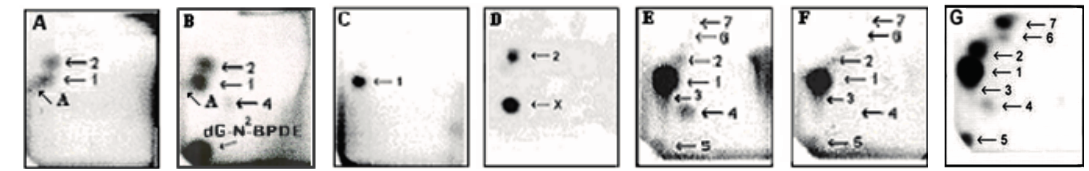
Figure 2. Autoradiographs of thin layer chromatography (TLC) maps of 32 P-labeled digests of calf thymus DNA reacted with ellipticine activated by hepatic microsomes from wild-type (WT) mice ( A ), with those from Hepatic Cytochrome P450 Reductase Null (HRN) mice pre-treated with benzo[a]pyrene (BaP) ( B ), from calf thymus DNA reacted with 13-hydroxyellipticine ( C ) [31] or 12-hydroxyellipticine ( D ) [32] of DNA from livers of WT ( E ) and HRN ( F ) mice treated intraperitoneally ( i.p. ) with 10 mg ellipticine/kg body weight [48] and of DNA from liver of Wistar rats treated i.p. with 40 mg ellipticine per kilogram body weight ( G ) [33,37]. Analyses were performed by the nuclease P1 version of the 32 P-postlabeling assay. Adduct spots 1–7 and A correspond to the ellipticine-derived DNA adducts. Besides adduct 2, another strong adduct (spot X in panel D ), which was not found in any other activation systems or in vivo was generated by